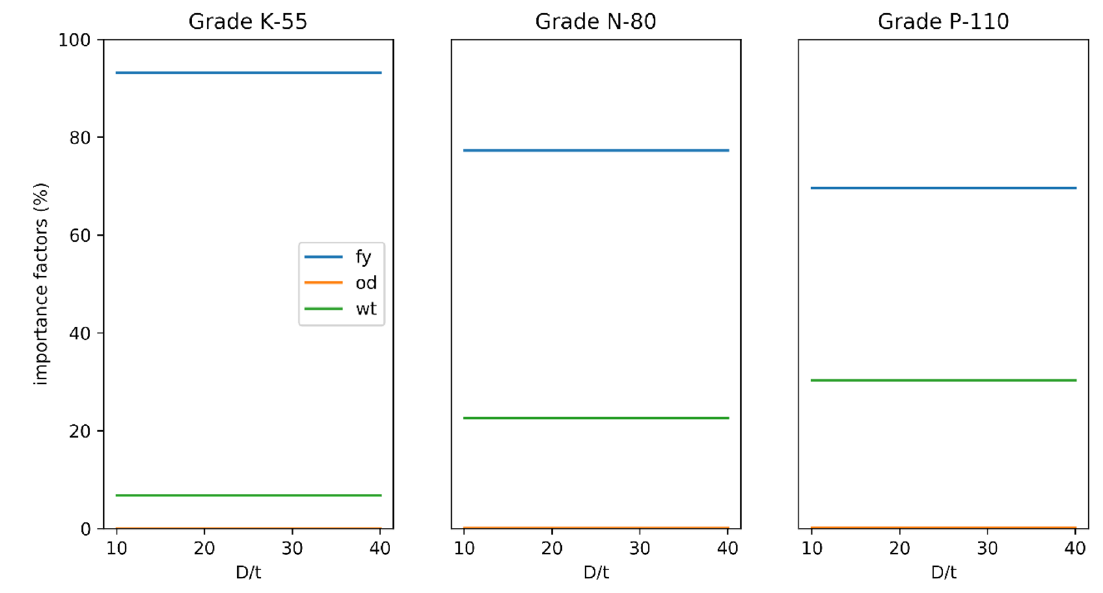
Fig. 8 Importance factors over D/t range for burst analysis